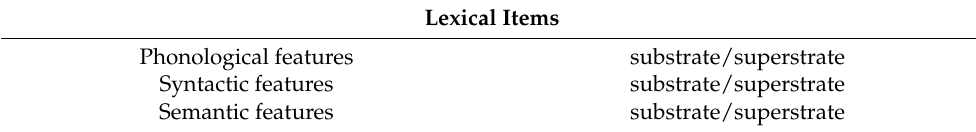
Table 1. The logical possibilities of feature-recombination in Aboh (2009, 2015). Lexical Items Phonological